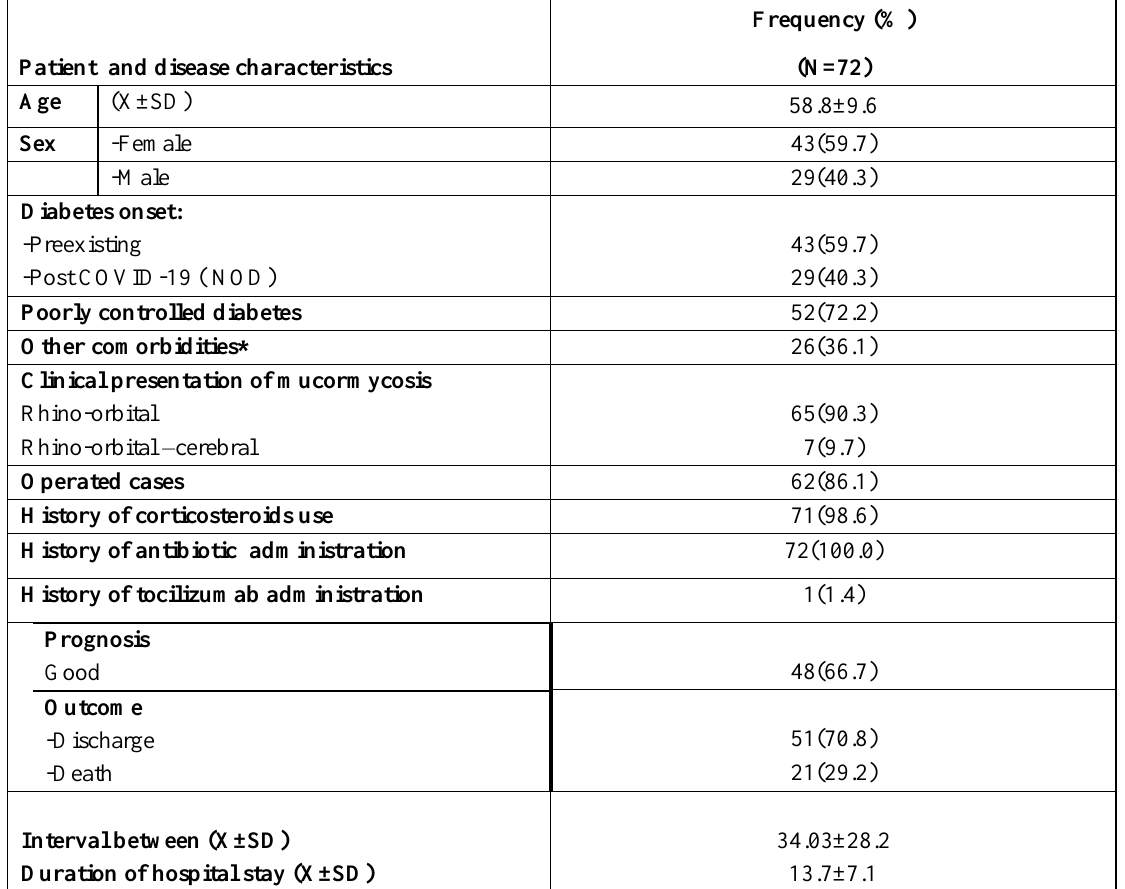
Table 1. Frequency distribution of patients and disease characteristics.